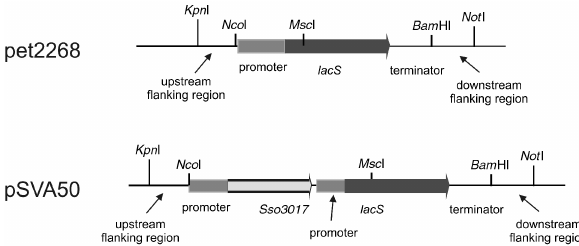
Figure 1. Schematic overview of the plasmids pET2268 and pSVA50 used for the isolation of gene deletion mutants in PBL2025. The Kpn I/ Nco I and Bam HI/ Not I restriction sites are used to clone the up- stream and downstream flanking regions of the target gene(s), respec-